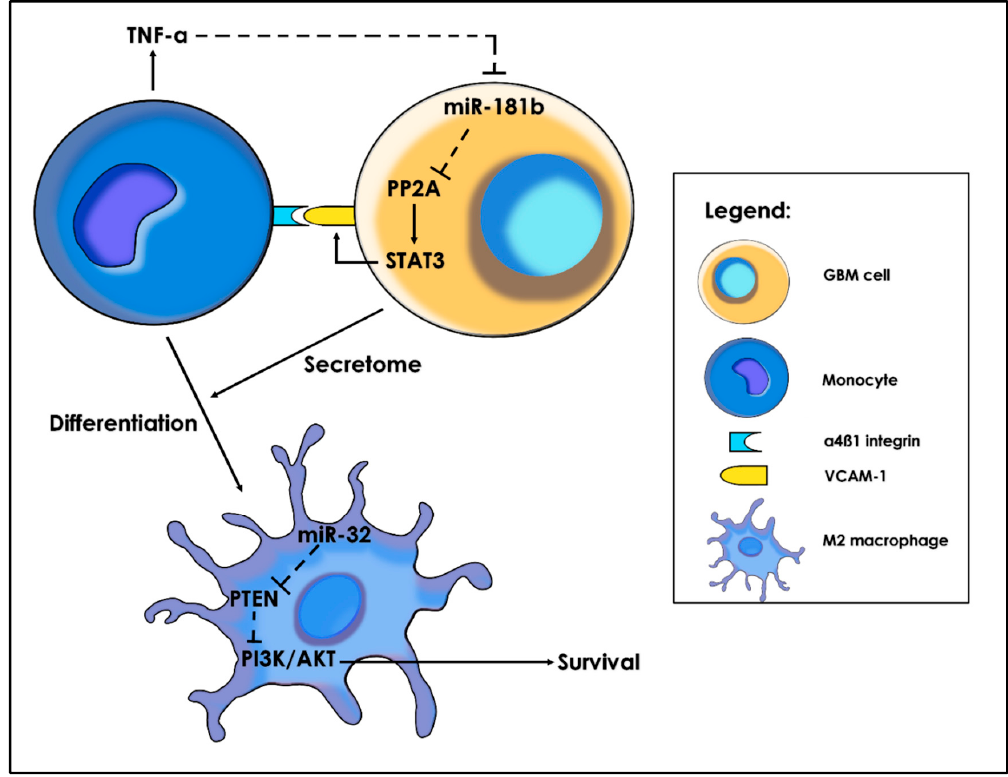
Figure 5. Vascular cell adhesion molecule 1 (VCAM-1)-mediated monocyte adhesion and differentiation towards the M2-macrophage (arrows—activation; dotted T-bars—inhibitory effect).